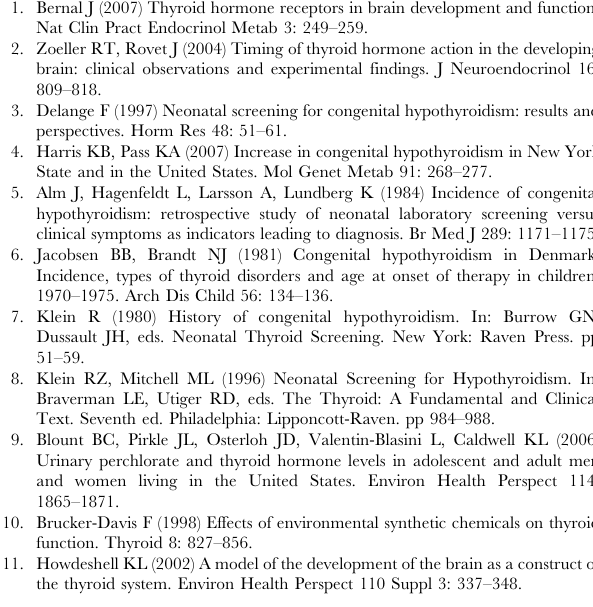
Table S1 ChIP PCR primers